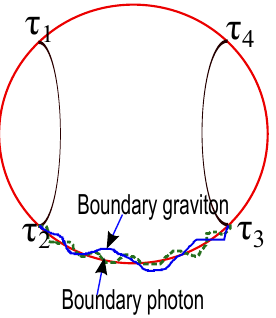
Figure 3 . Bulk description of OTO corre- Figure 4 . For the charged SYK model, the bulk description of OTO correlators of charged operators involves exchange of boundary gravitons and as well as of bound- ary photons. After appropriate rediagonal- ization, the gravitons and photons are decou- pled. The photons do not have any nontrivial pole and have zero Liapunov